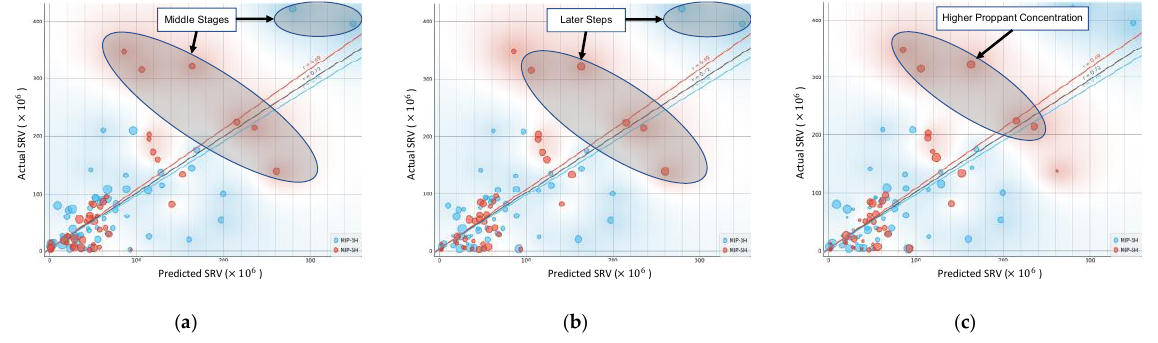
Figure 13. Further analysis of the models’ weak performances on well MIP-5H. Circle size represents: ( a ) stage, ( b ) step, and ( c ) proppant concentration. The x -axis in the plots shows the predicted values by the models, and the y -axis represents the actual values.